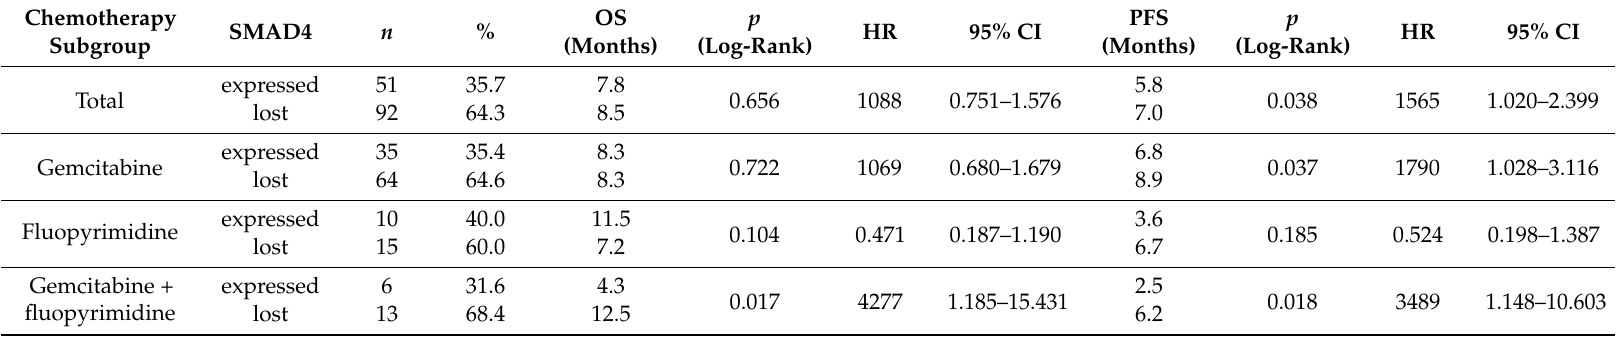
Table 2. Correlation of overall and progression-free survival (Kaplan–Meier estimates, log-rank tests and Cox regression) according to SMAD4 expression status (expressed vs. lost) in the total study population, the gemcitabine-based, fluoropyrimidine-based and gemcitabine–fluoropyrimidine-based treatment subgroups.